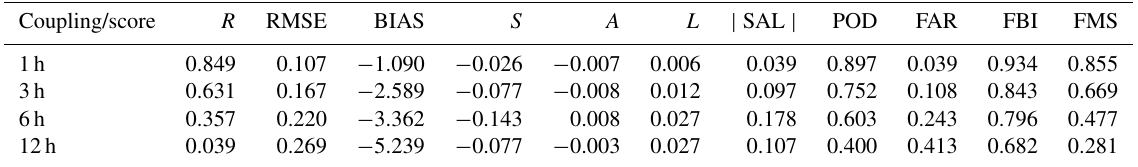
Table 3. Evaluation scores for the synthetic case at the end of the 48h forecast with NMMB-MONARCH-ASH. Metrics: Pearson’s correlation coefficient ( R ); root mean square error (RMSE); error bias (BiAS); structure ( S ); amplitude ( A ); location ( L ); absolute SAL ( | SAL | ); probability of detection (POD); false alarm ratio (FAR); frequency bias (FBI); and Figure of Merit in Space (FMS). Coupling/score